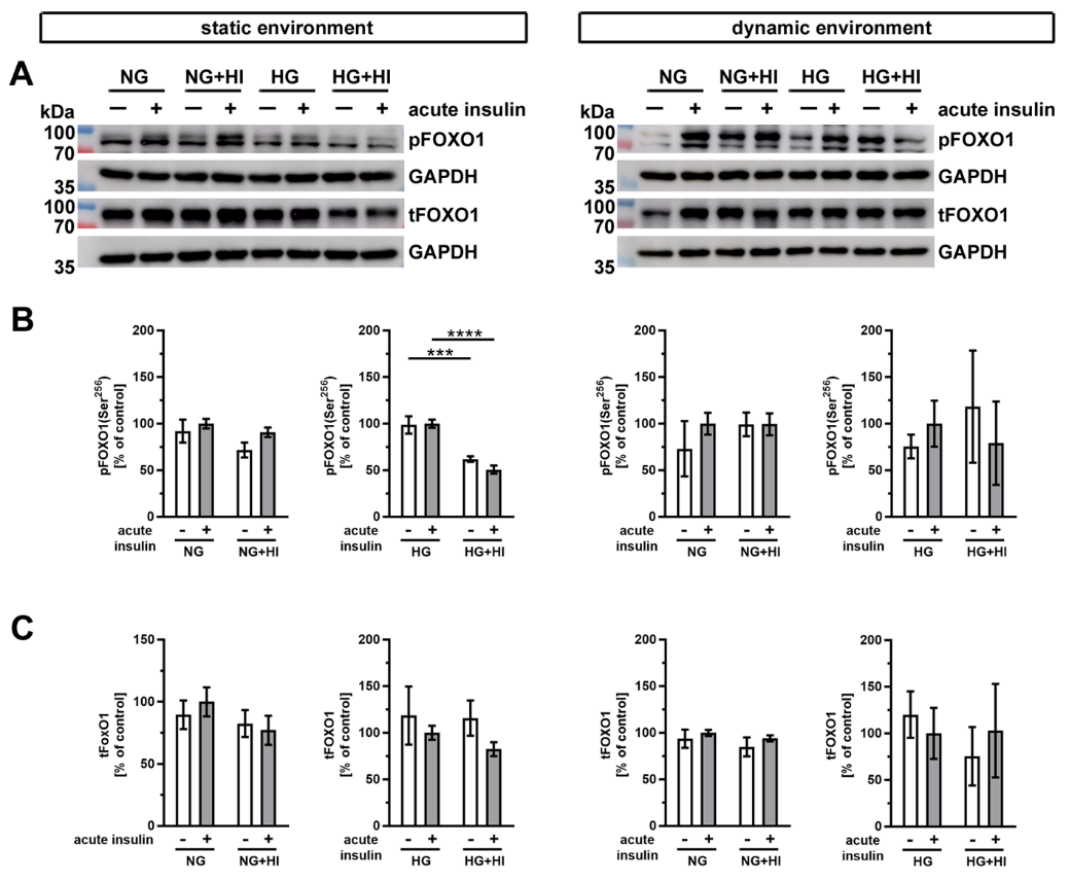
Figure 8. Activation of GSK3 α / β signaling. ( A ) Representative Western blot images display levels of GSK3 α / β phosphor- ylation under HI and HG and the respective expression of total GSK3 α / β protein. Lanes of protein ladders represent 55 kDa (pGSK3 α / β and tGSK3 α / β ) as well as 35 kDa (GAPDH). ( B , D ) Phosphorylation levels of GSK3 α and GSK3 β showed the insulin response of cultivated AV after acute insulin stimulation and were affected on the one hand by the chronic treatment with HI and HG and, on the other, by the cultivation environment (static versus dynamic flow). ( C , E ) Likewise, total GSK3 α and GSK3 β expressions of AV tissue were partially affected by diabetic conditions as well as the used culti- vation environment. Data were normalized to GAPDH and subsequently related to NG with acute insulin stimulus. n =